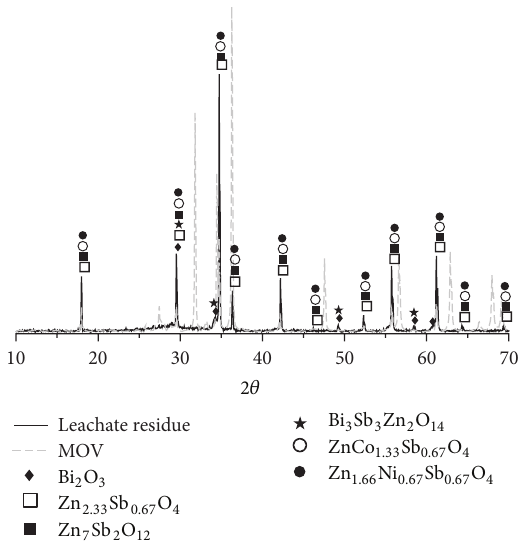
Figure 8: XRD spectrum (—) of leaching residue (pH 1, sulfuric acid) compared to XRD spectrum of nonleached starting material (- - -). Chemical compounds are represented as follows: Bi 2 O 3 ( X ), Zn 2.33 Sb 0.67 O 4 ( ◻ ), and Zn 7 Sb 2 O 12 ( ◼